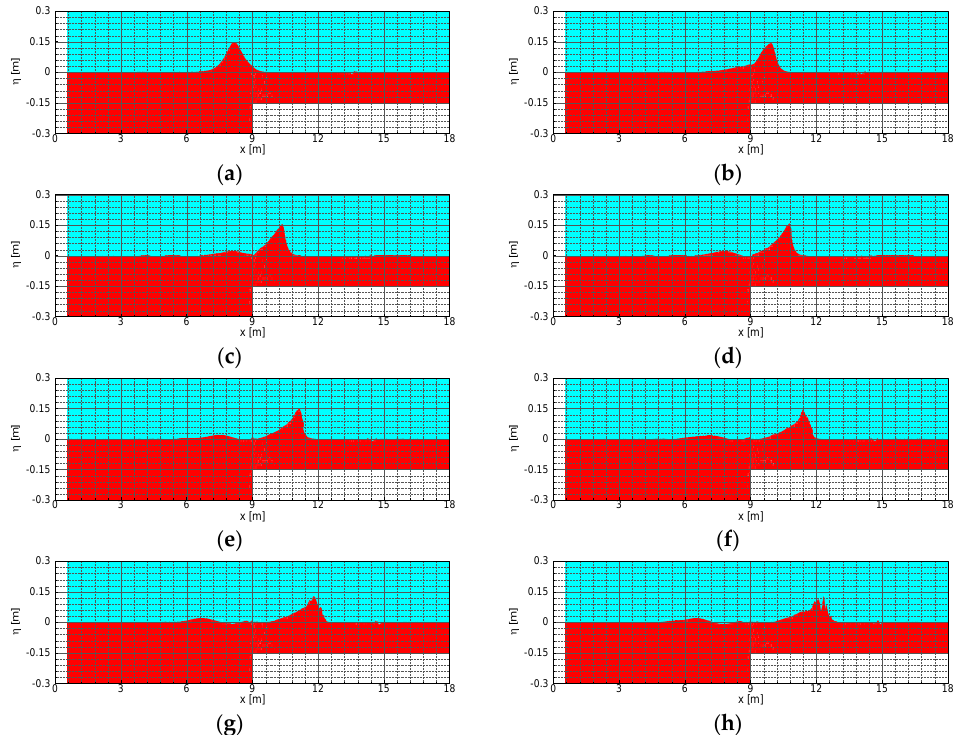
Figure 12. The snapshots of the solitary wave propagating from the deep water into the shallow water. ( a ) t = 6 s; ( b ) t = 6.8 s; ( c ) t = 7 s; ( d ) t = 7.2 s; ( e ) t = 7.4 s; ( f ) t = 7.6 s; ( g ) t = 7.8 s; ( h ) t = 8 s. When the solitary wave propagates from the deep water into the shallow water, a part of the solitary wave is reflected because the blockage effects make the road narrower. After the main wave enters the shallow water, the moving speed of its crest looks faster than that of its trough if observing the wave profiles from t = 6.8 s to t = 7.2 s. This means that the crest loses the support of the trough so that the crest at t = 7.4 s and t = 7.6 s tends to fall down due to gravity. This leads to the collapse of the main wave. The wave profiles for the waters of constant depth and variable depth at t = 7.2 s are compared in Figure 13. As is seen, the trough of the wave in the step-type flume moves slightly slower than the trough in the water of constant depth, whereas the crest in the step-type flume moves faster. Note that the speed of the whole solitary wave (both the crest and trough) in the water with the constant depth is always consistent.